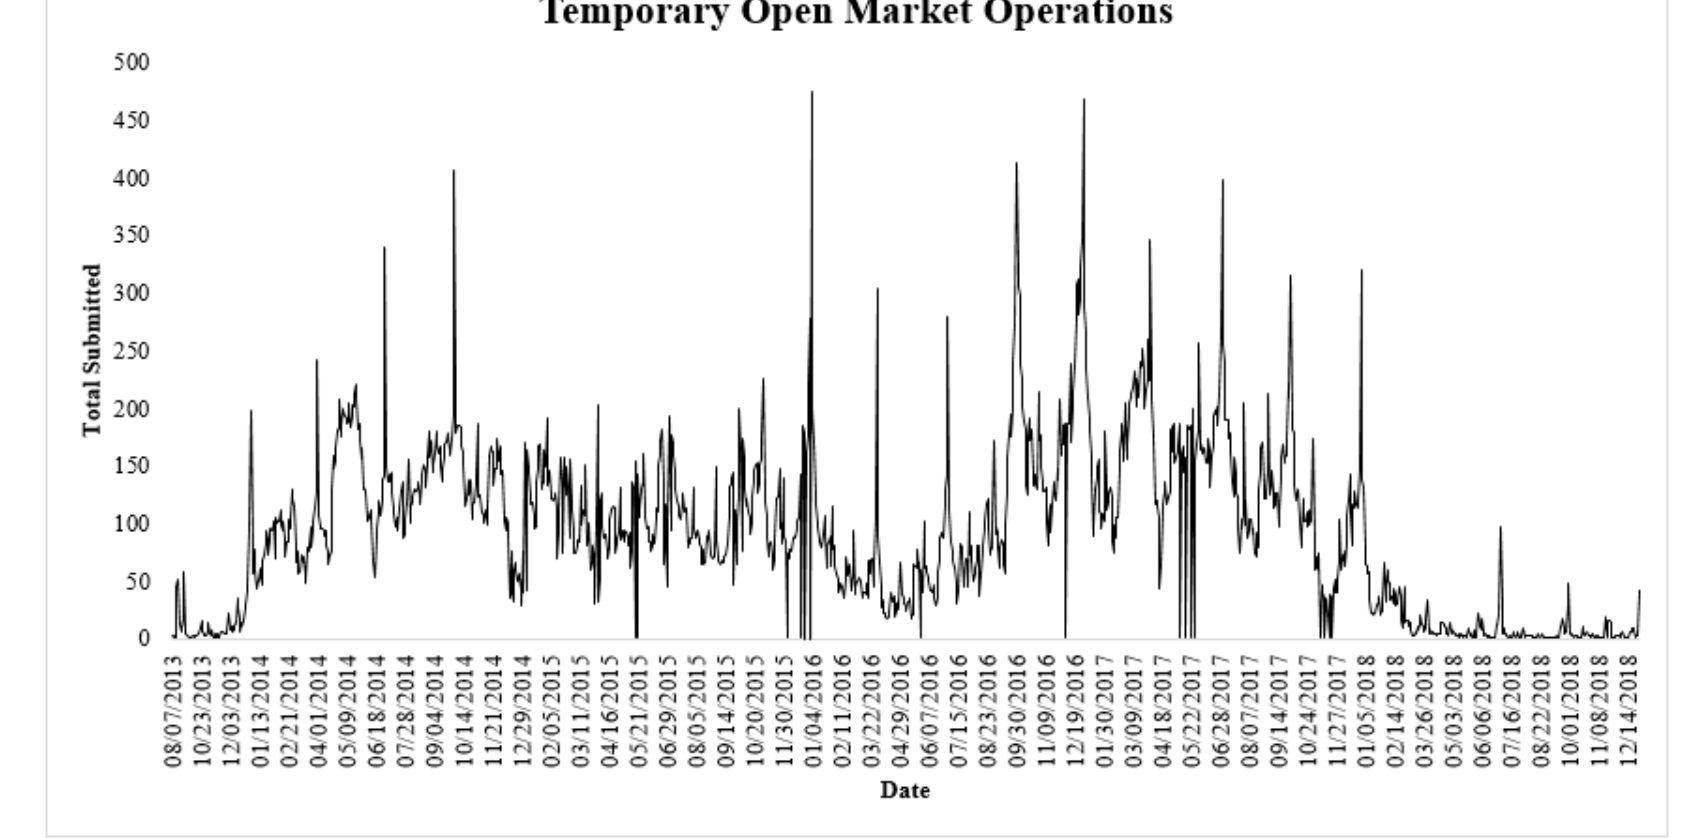
Figure 1. Time Series Plots of total orders submitted by the Federal Reserve under its open market operations.